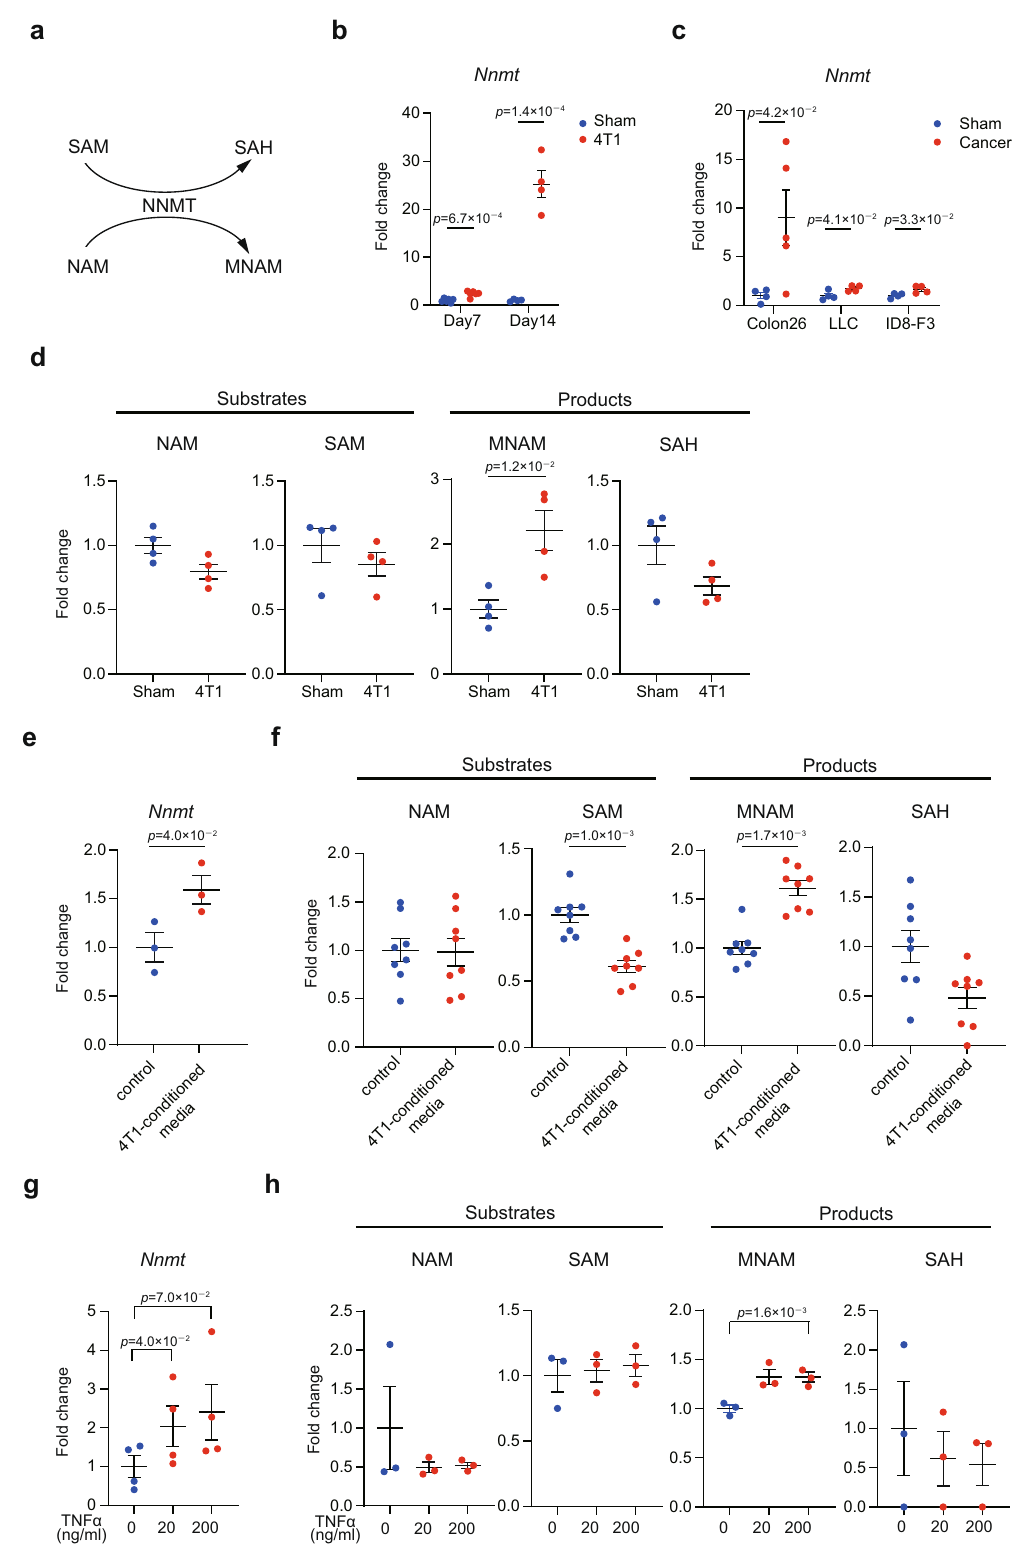
4T1 breast cancer-bearing condition (Supplementary Fig.